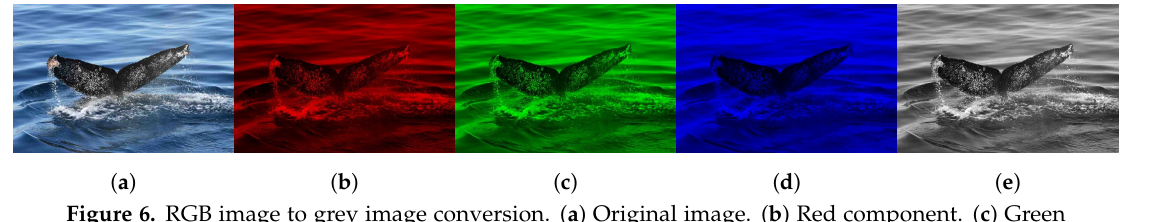
Figure 6. RGB image to grey image conversion. ( a ) Original image. ( b ) Red component. ( c ) Green component. ( d ) Blue component. ( e ) Grey image.